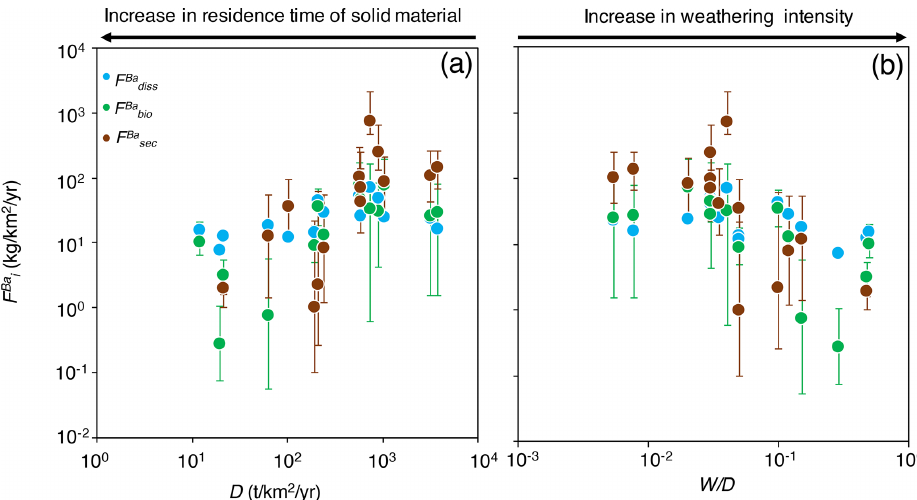
Figure 5. Fluxes of Ba in the Critical Zone ( F Ba ) for dissolved export ( diss ) , the formation of secondary weathering products such as clays i or oxides ( sec ) , and biological uptake ( bio ) , from Eq. (9), vs. (a) D (denudation) and (b) W/D (weathering intensity) in the Amazon Basin. D and W/D values are taken from Wittmann et al. (2011) and Dellinger et al. (2015b). Uncertainties on F Ba have been evaluated using i Monte Carlo error propagation based on the uncertainties on individual parameters (Appendix B; Table S2). Negative median values of F Ba i are not plotted here because of the logarithmic